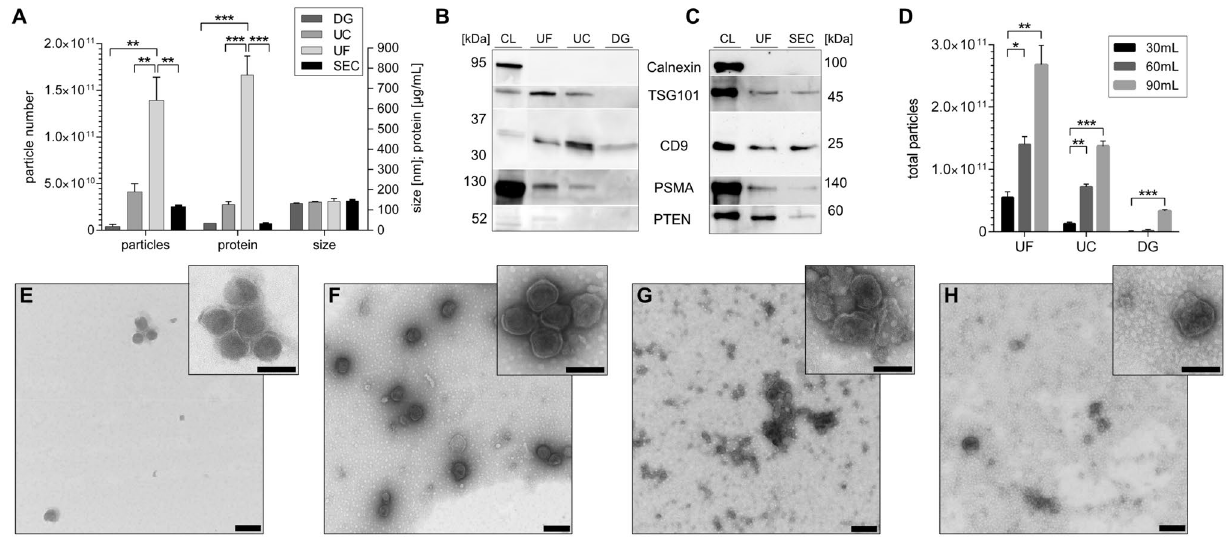
Figure 2. Comparison of EV isolation methods from 22Rv1 cell culture supernatant after 24 h of serum-free incubation. Density gradient centrifugation (DG), differential ultracentrifugation (UC), ultrafiltration (UF) using a MWCO of 100 kDa and its combination with size exclusion chromatography (SEC) analyzed based on NTA data and protein concentration ( A ), western blot of 1E + 9 particles ( B,C ), total particle number per starting volume of supernatant ( D ) and transmission electron microscopy of DG ( E ), UC ( F ), UF ( G ) and SEC ( H ) samples of 16 k fold magnification with scale bars of 200 nm in the big square and 40 k fold magnification with scale bars of 100 nm in the small square (n = 2 ± SD). Statistical differences were analyzed using one-way ANOVA with a P value equal ≤ 0.005 *, 0.01 ** and 0.001